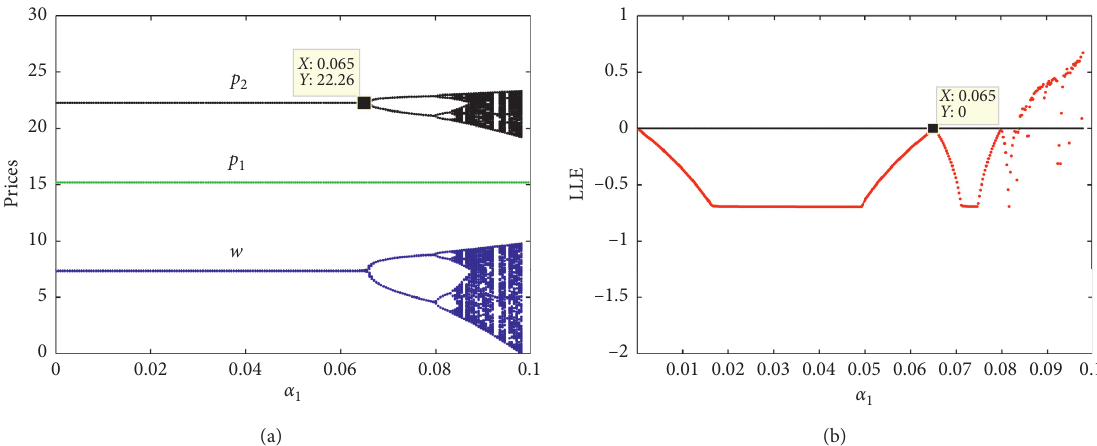
Figure 3: The behavior of dynamic system (9) with respect to α